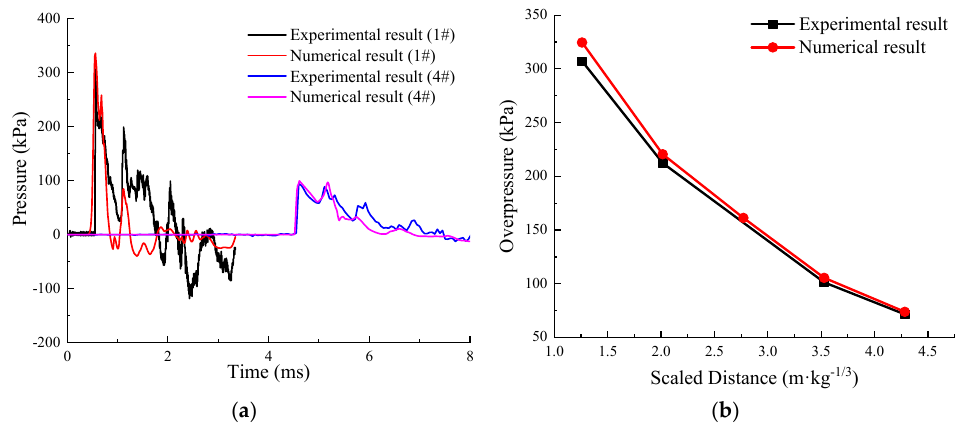
Figure 17. Comparison of experiment and numerical simulation. ( a ) Comparison of overpressure time-history curves of 1# and 4# gauge; ( b ) comparison of overpressure peak in the 0° direction.